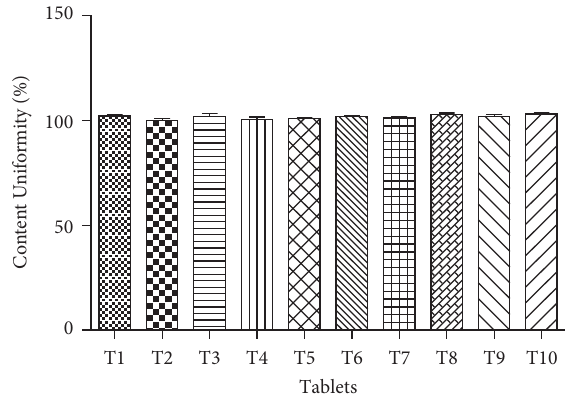
Figure 5: Content uniformity (%) of different formulation of